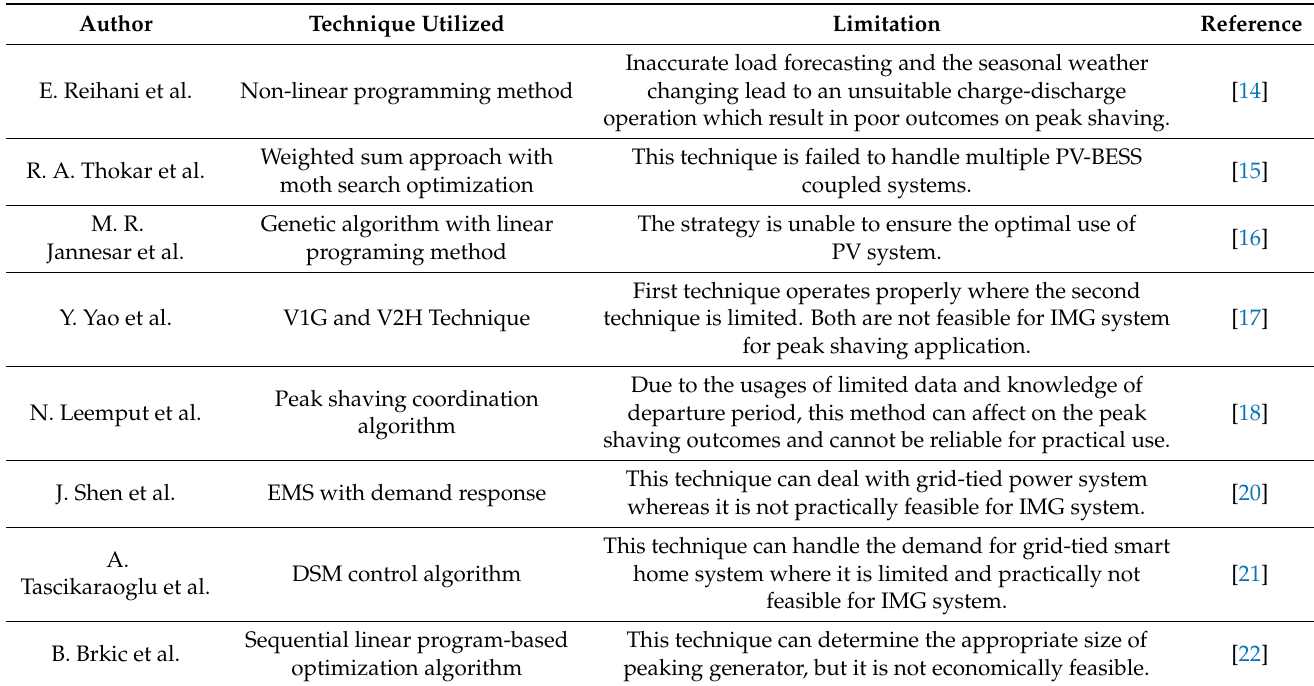
Table 1. Summary of some existing research on peak